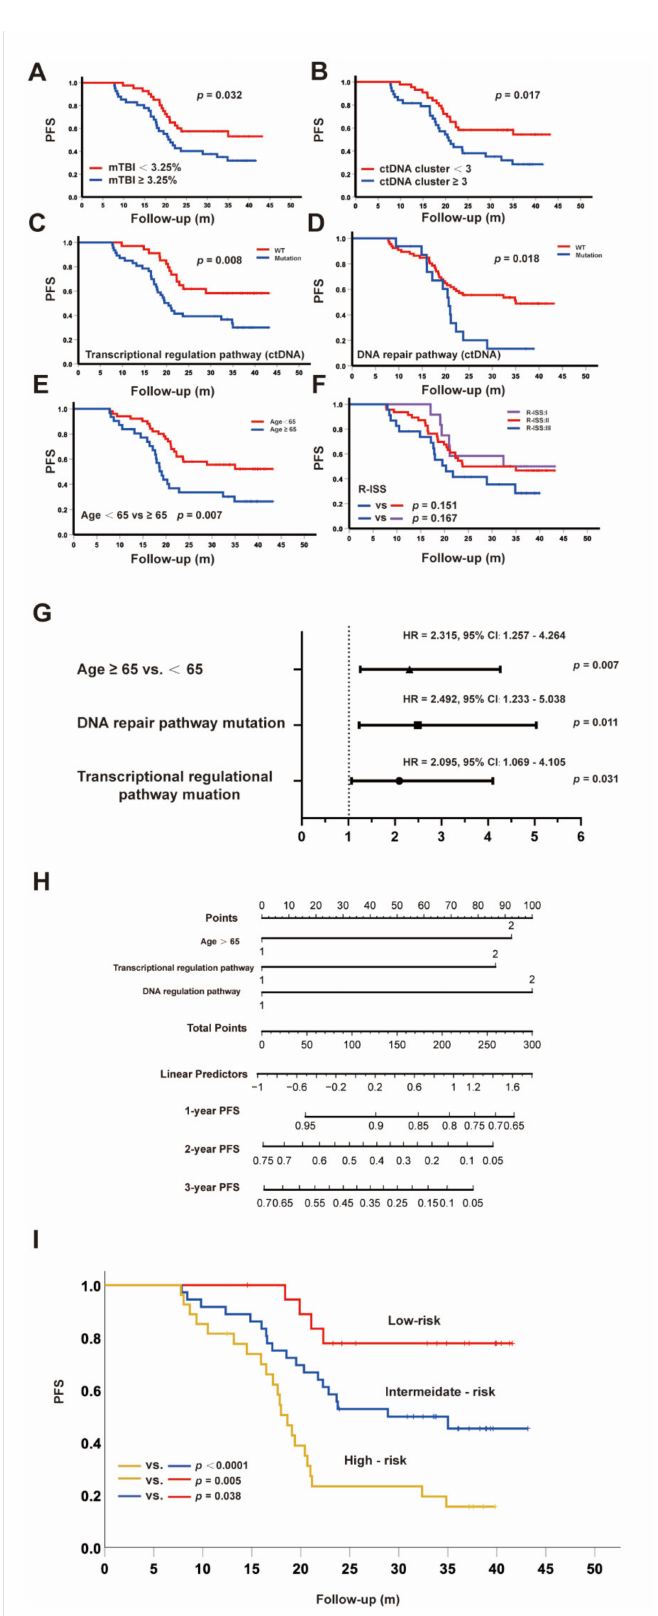
Figure 6. Multidimensional analysis of prognostic factors for PFS: ( A – F ) Kaplan–Meier curves for PFS according to the different factors; ( G ) Independent risk factors for PFS with different Hazard Ratios; ( H ) Nomogram models to predict PFS; ( I ) Kaplan–Meier curves for PFS according to risk